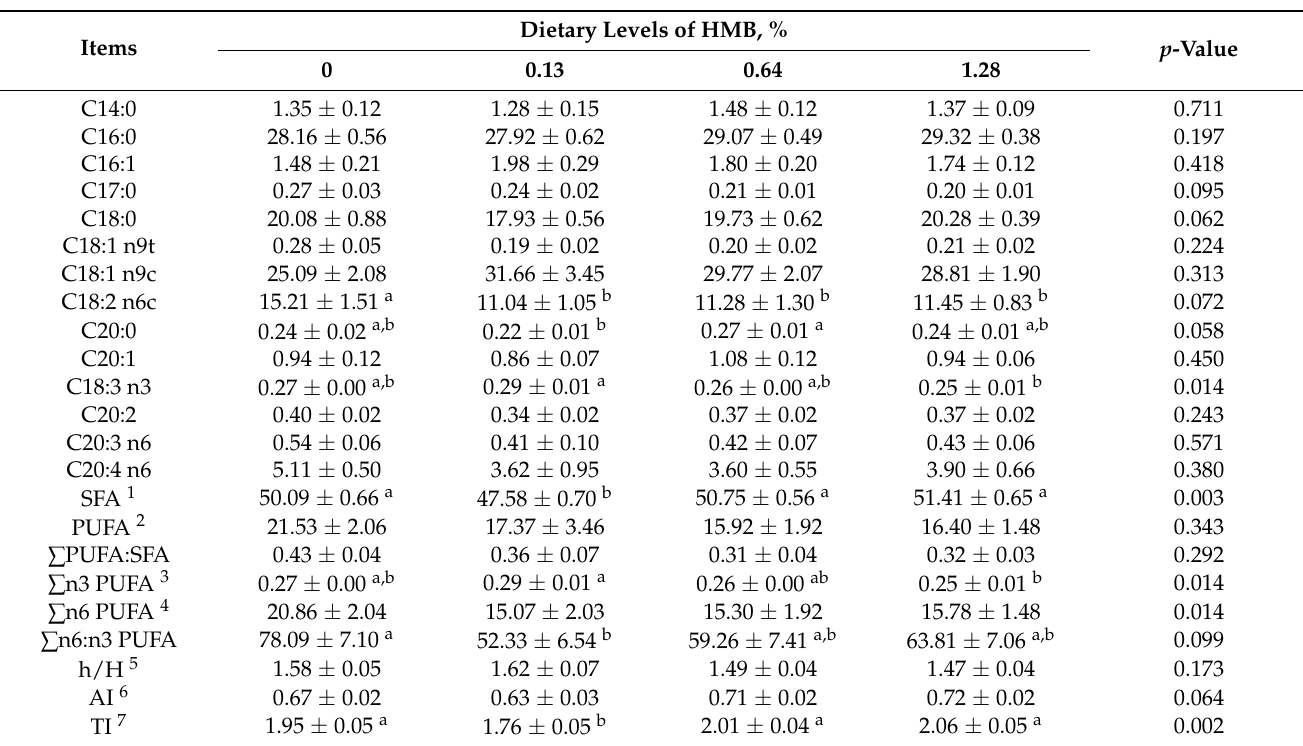
Table 5. Fatty acid composition of Soleus muscle in Bama Xiang mini-pigs fed the diets with various levels of HMB (% of total fatty acids) ( n =